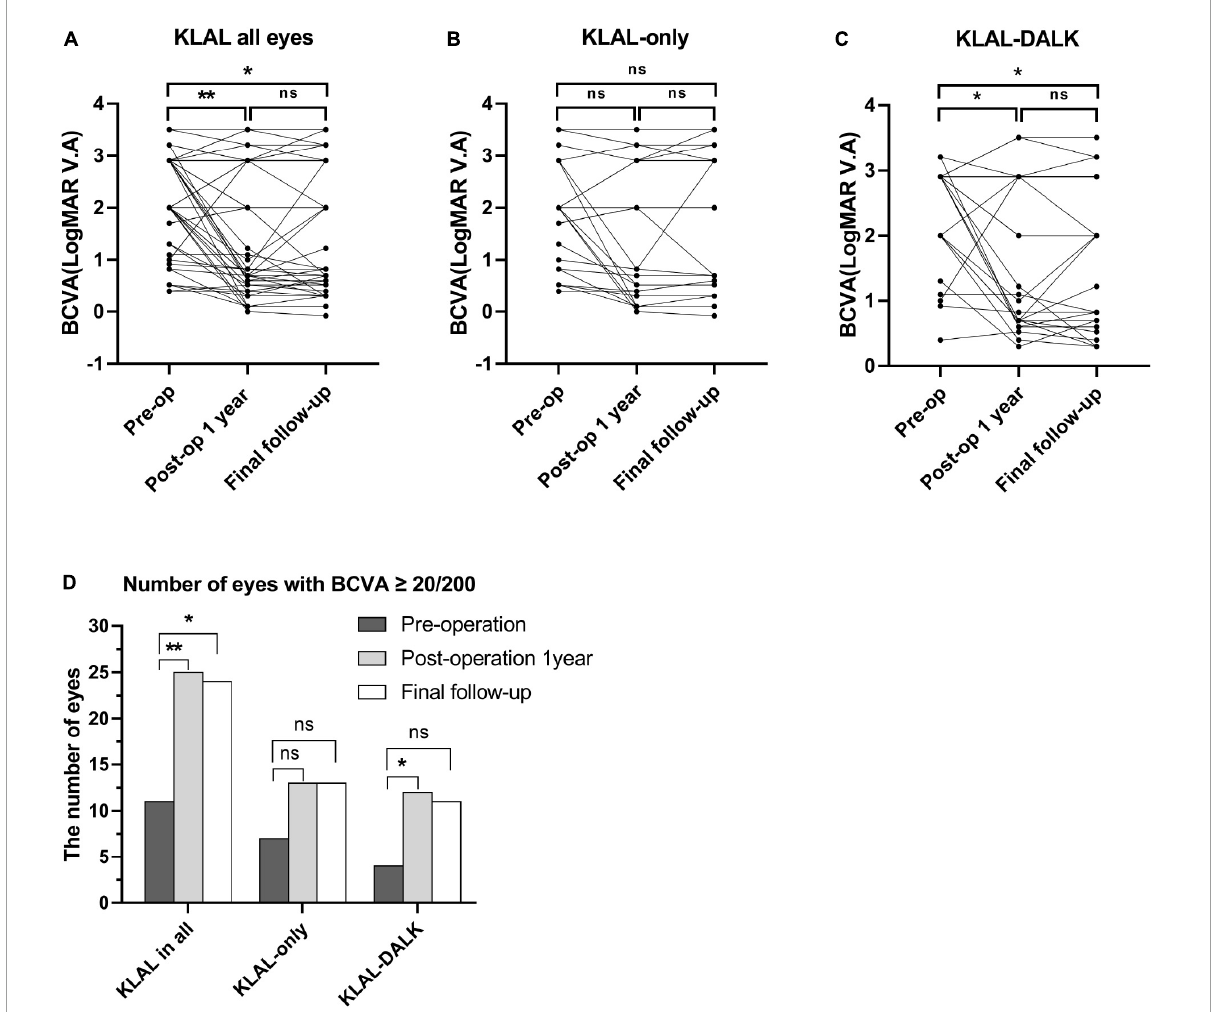
FIGURE3 BCVA preoperatively and at the 1-year and final follow-up after KLAL transplantation in all eyes. In the whole patient cohort ( n = 49), the BCVA at 1 year postoperation ( P = 0.002) and at the final follow-up ( P = 0.01) was significantly improved compared with that preoperation (A) . For the KLAL-only group ( n = 24), the BCVA improved postoperatively but was not significantly different from that preoperatively ( P = 0.06, 0.17) (B) . For the KLAL-DALK group ( n = 25), the BCVA at 1 year postoperation ( P = 0.02) and at the final follow-up ( P = 0.03) was significantly improved compared with that preoperation (C) . The number of eyes with a BCVA ≥ 20/200 preoperatively, postoperatively, 1 year postoperatively and at the final follow-up (D) . Data are presented in dot plots including all individual points (* p < 0.05, ** p < 0.01). A Wilcoxon matched-pairs signed rank test was used to compare the postoperative and preoperative BCVA values. BCVA, best corrected visual acuity; KLAL, keratolimbal allograft; DALK, deep anterior lamellar